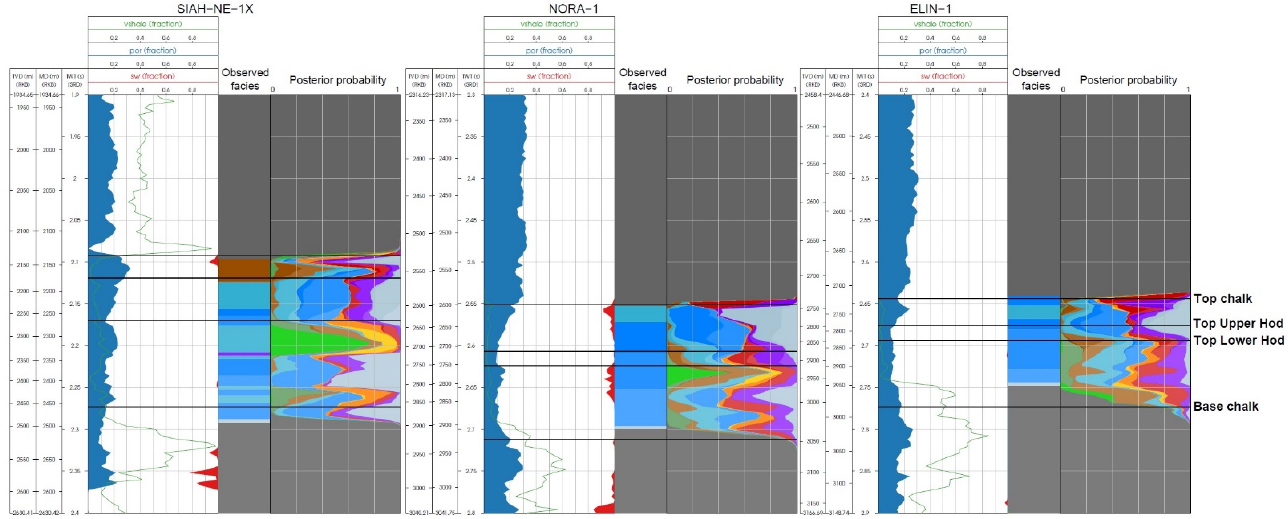
Figure 17. Inversion results for the Siah-NE-1X ( left ), Nora-1 ( middle ) and Elin-1 ( right ) wells. For each well, from left-to-right, shale volume (vclay), porosity (por) and water saturation logs; observed (or reference) facies profile; and the posterior probabilities as a function of time/depth. The four seismic surfaces are plotted: Top Chalk, Top Upper Hod, Top Lower Hod and Base Chalk.